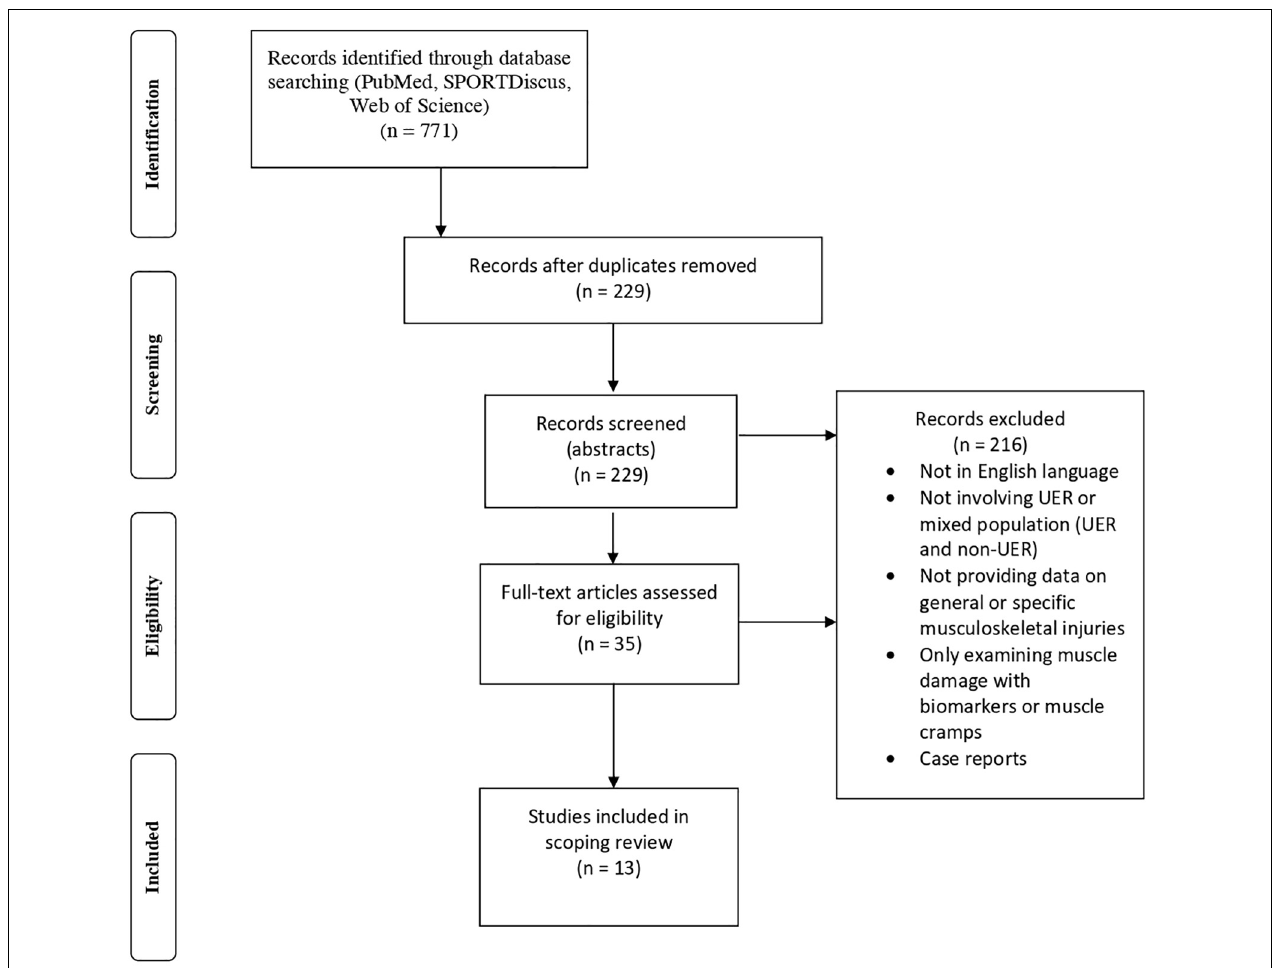
FIGURE 1 | Flow chart of article selection process [adapted from Moher et al.